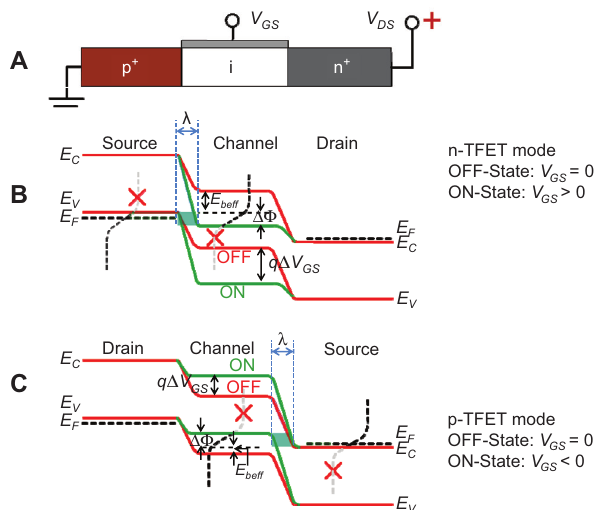
Figure 3 (A) Schematic cross-section of a TFET structure with applied source ( V ), gate ( V ) and drain ( V ) voltages. (B) Sche- S GS DS = 0 matic energy band diagram for the OFF-state (red lines with V GS > 0) and ON-state (green lines with V > 0 and V > 0) of and V DS GS DS n-type TFET. (C) Schematic energy band diagram for the OFF-state = 0 and V > 0) and ON-state (green lines with (red lines with V GS DS < 0 and V > 0) of p-type TFET. Reprinted from Ref. [5] and Ref. V GS DS [18], with permission, from Nature and IEEE,